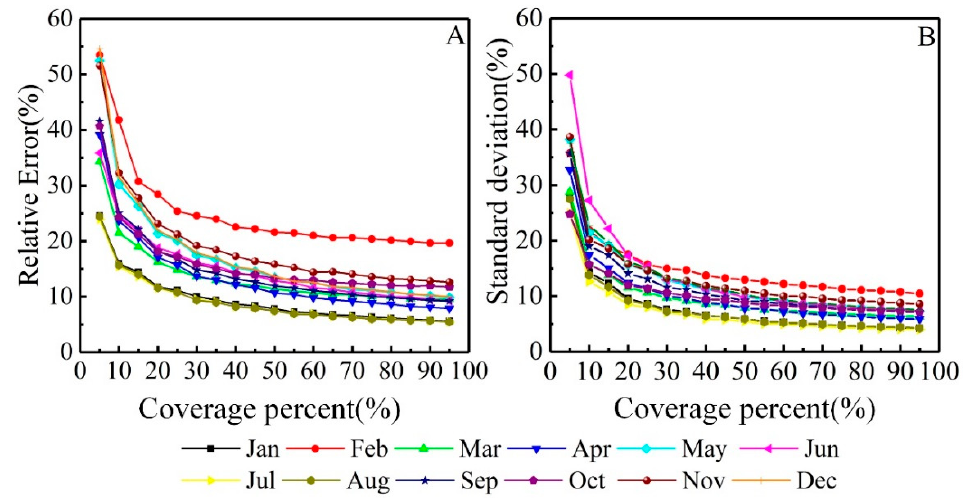
Figure 10. Monthly relative errors ( A ) and standard deviations ( B ) under different coverage of satellite observations.